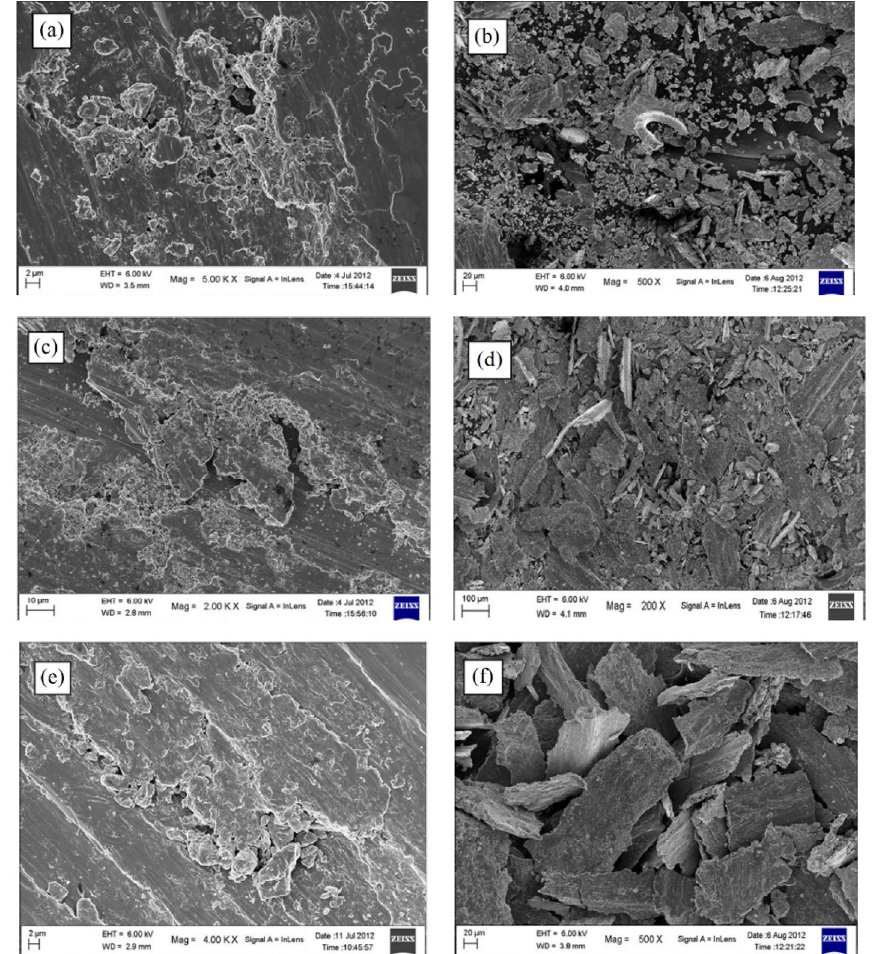
Fig. 17 FESEM metallographic images of worn-pin surface and wear debris developed from Ti64 specimen (bi-modal microstructured) at distinct sliding conditions: (a) and (b) load = 60 N, speed = 0.3 m·s − 1 ; (c) and (d) load = 60 N, speed = 0.6 m·s − 1 ; (e) and (f) load = 60 N, speed = 0.9 m·s − 1 . Reproduced with permission from Ref. [21]. Copyright Springer Nature,